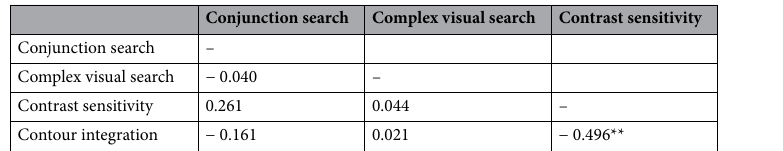
Table 2. Pearson’s correlations between all four outcome measures at pre-test. **p < 0.01.